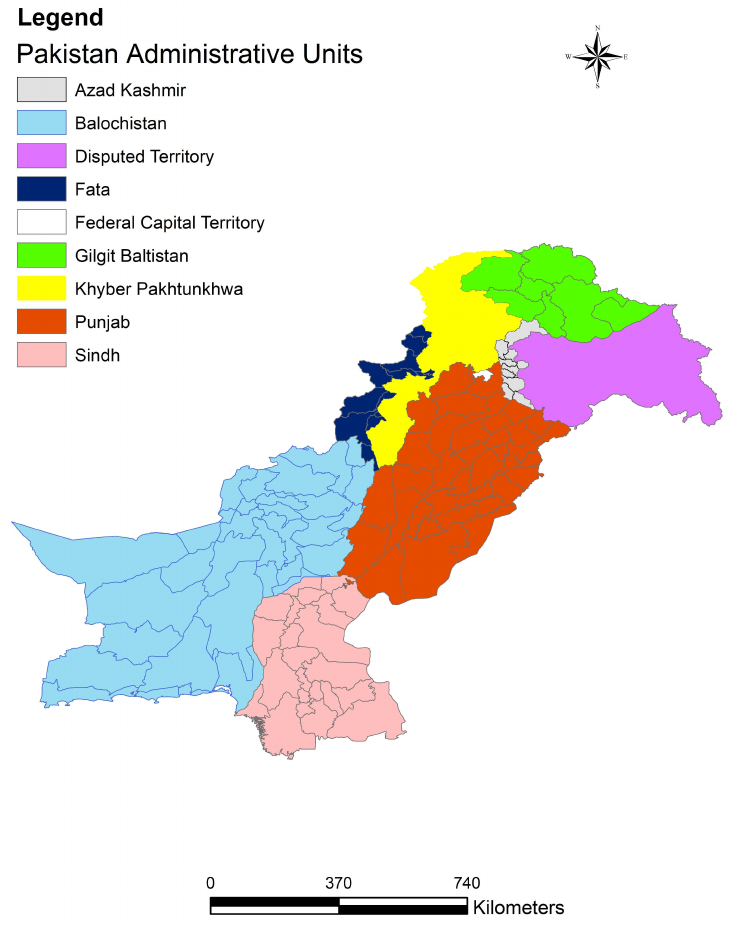
Figure 1. The administrative units in